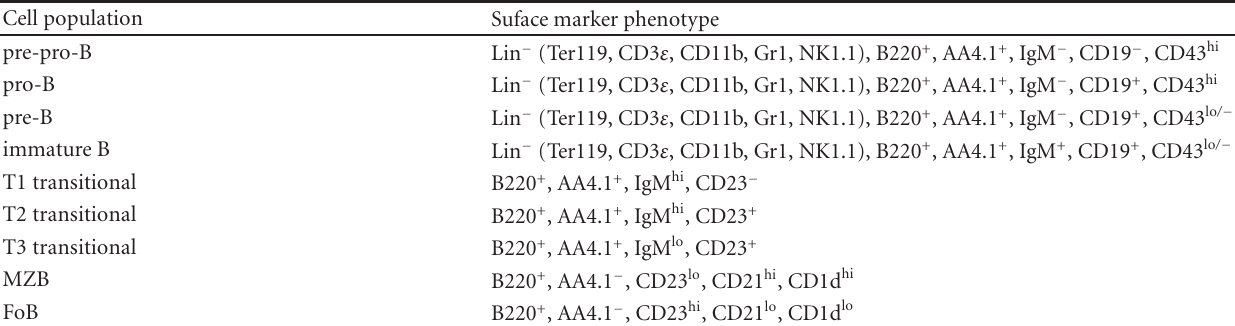
Figure 6: Pc AS infection-induced apoptosis of transitional B cells. Spleens cells from uninfected control mice and mice infected with Pc AS were stained for surface markers commonly used to define transitional T2 B cells and the amount of active caspase 1, -3, -4, -5, -6, -7, -8 and -9 was measured intracellular by flowcytometry. (a) Percentage of apoptotic cells within T2 transitional B-cell population in uninfected controls versus infected mice on day 11 and 41pi. Data are represented as mean of three mice per group ± SEM ( ∗∗∗ ) P < . 001 and representative of two separate experiments. (b) Representative histogram of uninfected controls (grey line) versus a day 11 pi (black line). Table 1: Di ff erentiation antigen phenotypes of developing and mature B2 B